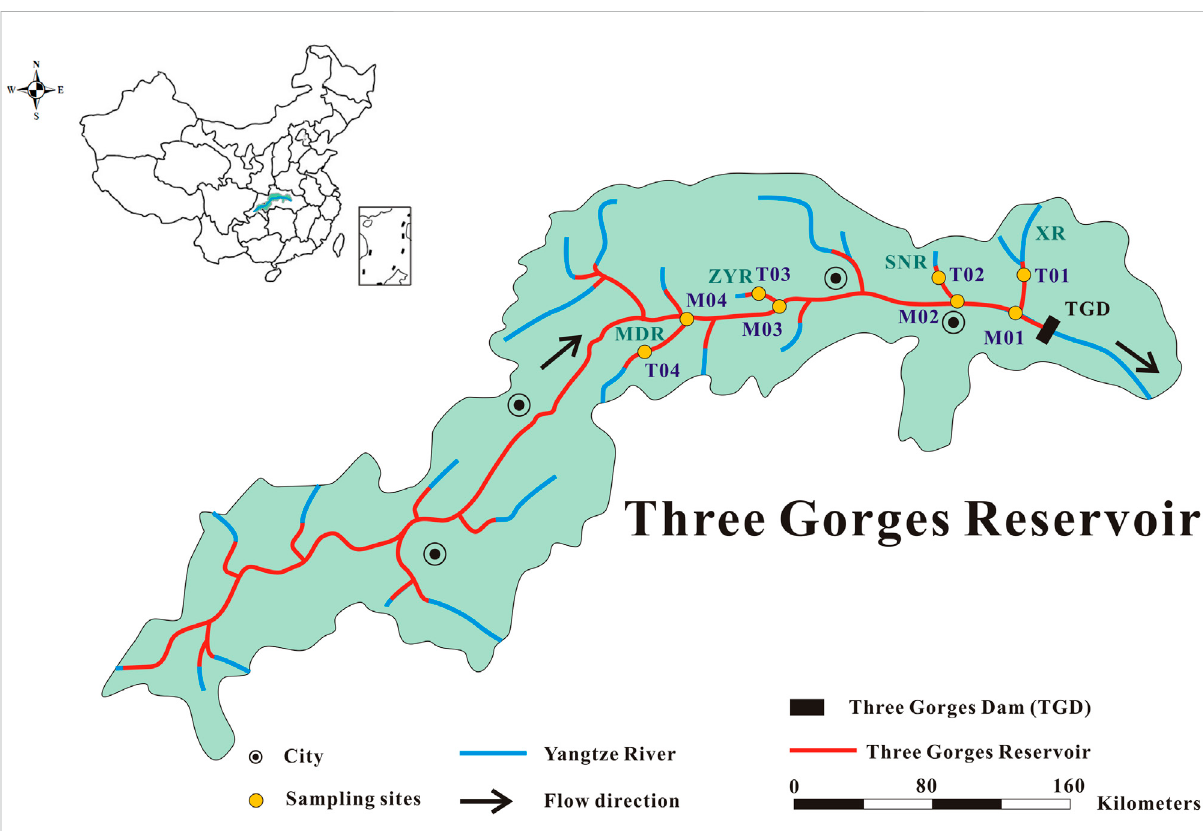
FIGURE 1 Study area and sampling sites in TGR. Sampling sites were selected in XR (M01, T01), SNR (M02, T02), ZYR (M03, T03), and MDR (M04,